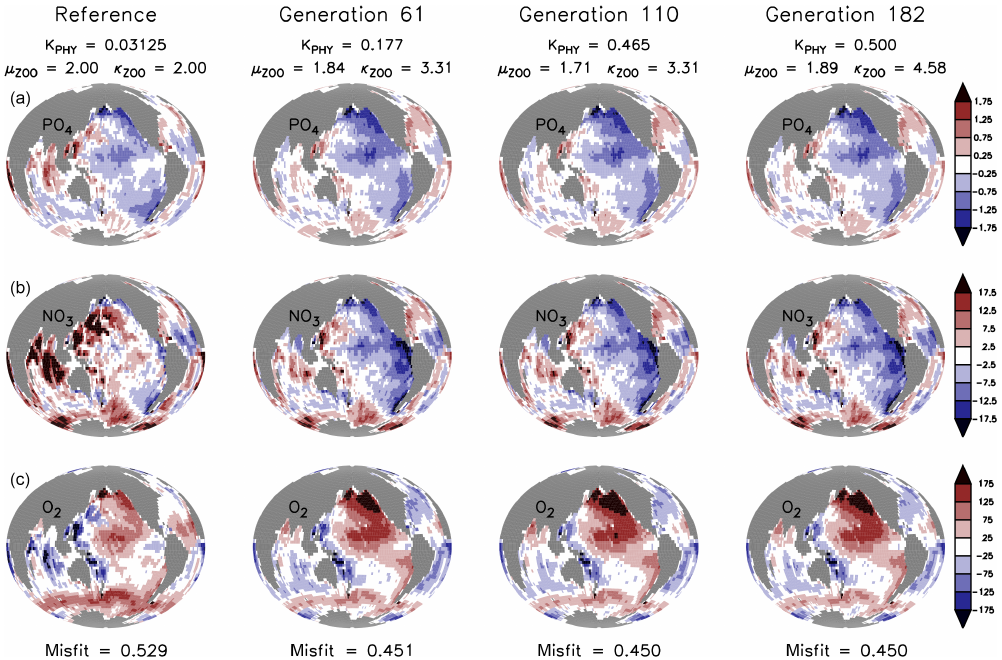
Figure 16. Model deviations from observations of vertically integrated phosphate (top), nitrate (middle), and oxygen (bottom) for the refer- ence run, and three generations (61, 110, 182) of OBS-NARR. See the blue lines in Fig. 14 for parameter values in this generation. For each generation, we chose the best (with respect to misfit) individual for plotting. The misfit is 0.451, 0.450, and 0.450 for generations 61, 110, and 182,